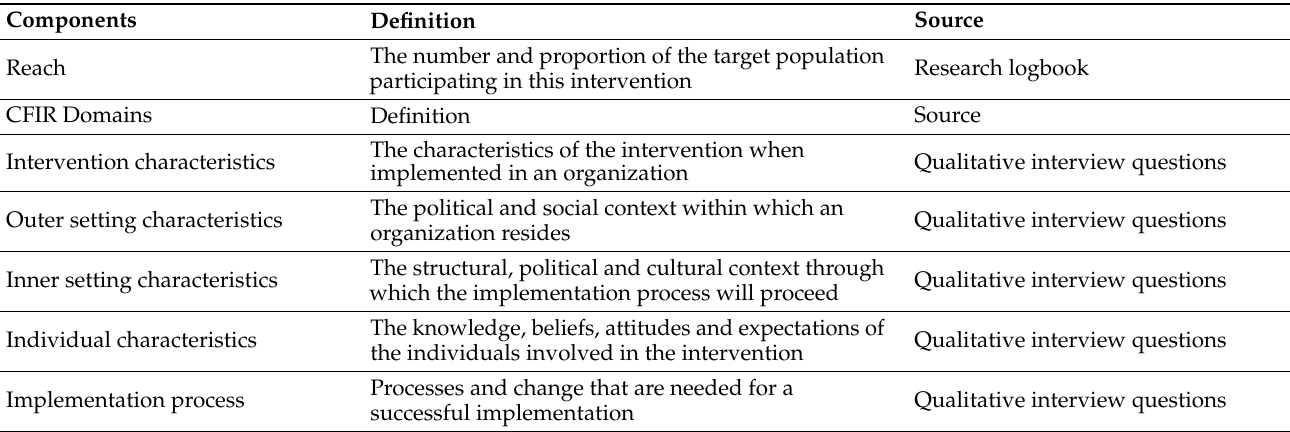
Table 1. Components of the process evaluation, including CFIR domains [17].